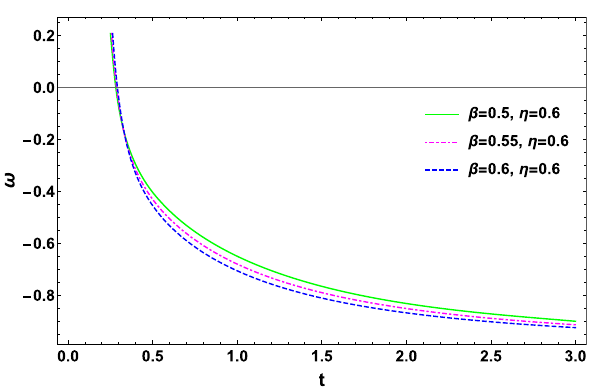
Fig. 17 Variation of pressure against z with m = 0 . 2, n = 0 . 05, λ = 0 . 5